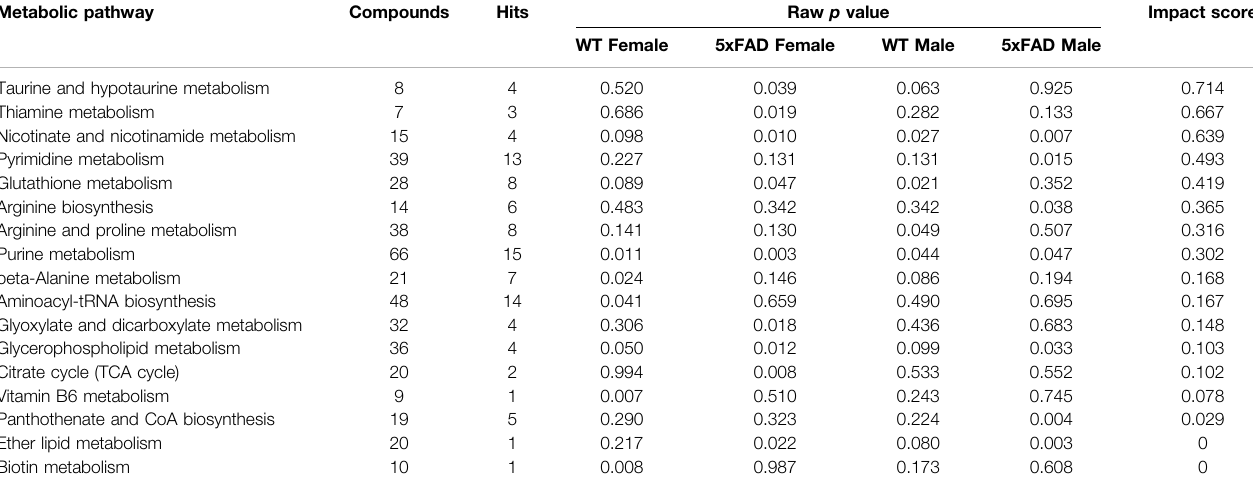
TABLE 3 | Pathway analysis in mice treated with CAW (500 mg/kg) vs. sex- and genotype-matched untreated controls. Metabolic pathway